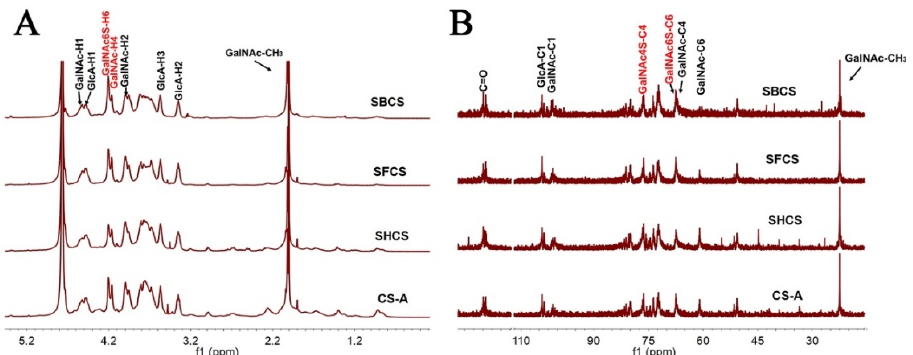
Figure 5. NMR analysis of three CSs and CS-A. ( A ) 1 H NMR spectra. ( B ) 13 C NMR spectra.